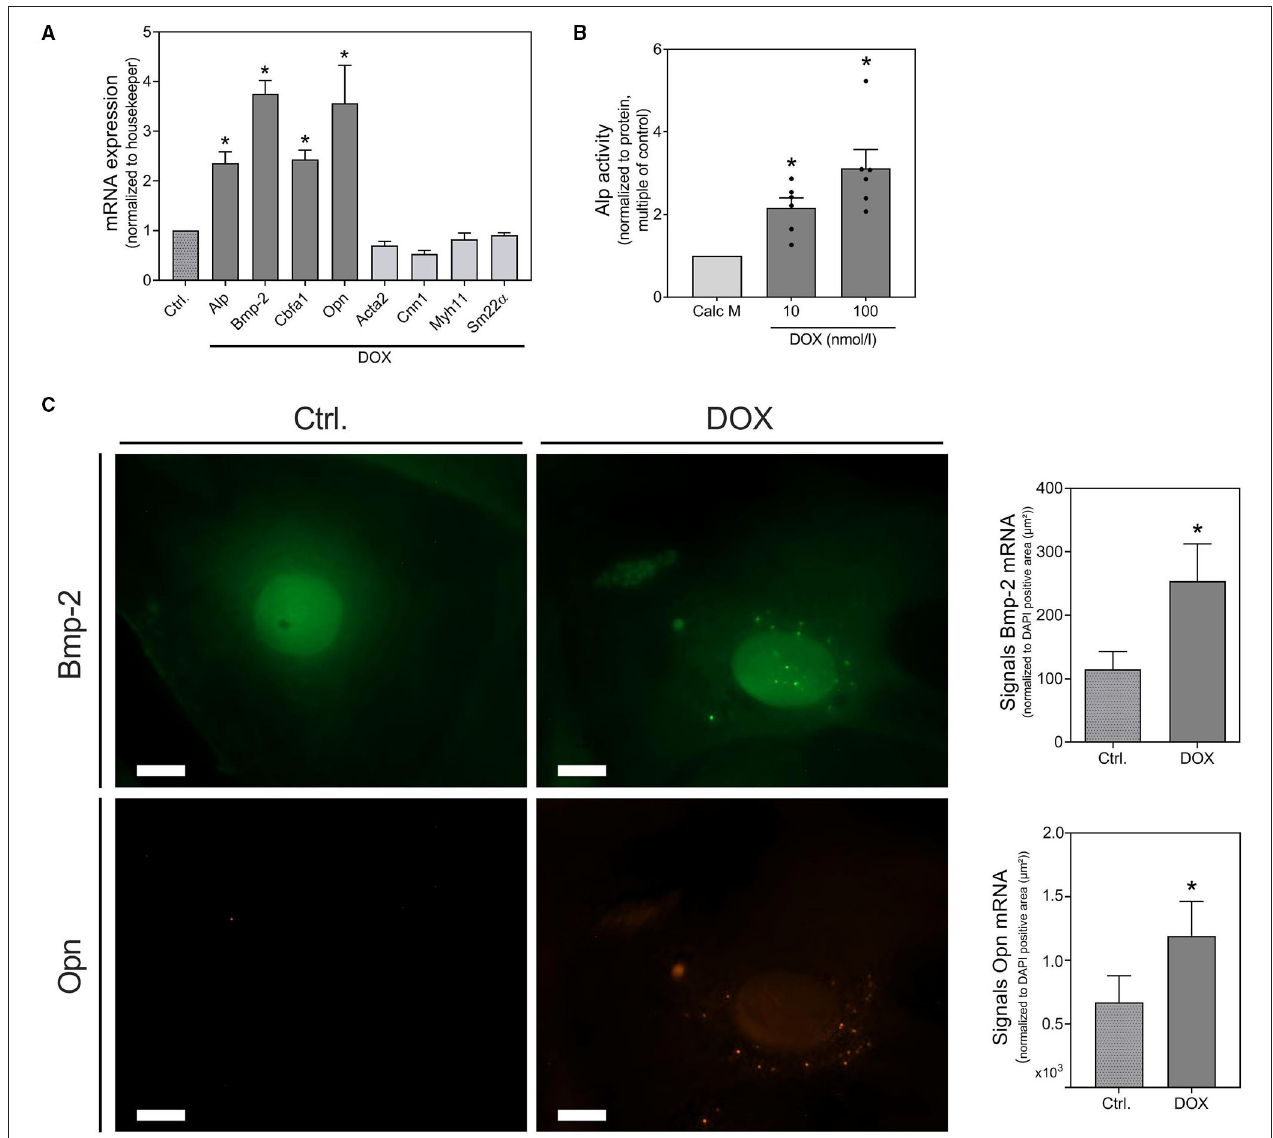
FIGURE 2 | Induction of osteoblastic trans-differentiation by doxorubicin. VSMCs were stimulated in quiescence medium (A,C) or calcification medium (B) with DOX as indicated or 1,000 nmol/l for 48h (A,C) or 14 d (B) . mRNA expression was measured with quantitative real-time PCR (A) . Measured thresholds of the respective targets were normalized to the corresponding threshold of housekeeper gene actin before normalization to control (A) . Alp activity was measured with a p-nitrophenyl phosphate-based Alp Assay and normalized to protein content ( µ g/ µ l) before normalization to control (B) . mRNA expression of Bmp-2 and Opn were visualized with RNA in situ hybridization staining and were quantified by counting signal dots per whole image, normalized to the DAPI positive cell core area per image ( µ m 2 ) (C) . Data represent mean ± SEM, n ≥ 3, * p < 0.05 vs. control. Pictures show a section of a representative experiment of n ≥ 3, the scale bar indicates a 10 µ m section (C) . Full representative images are shown in Supplementary Table 3 .